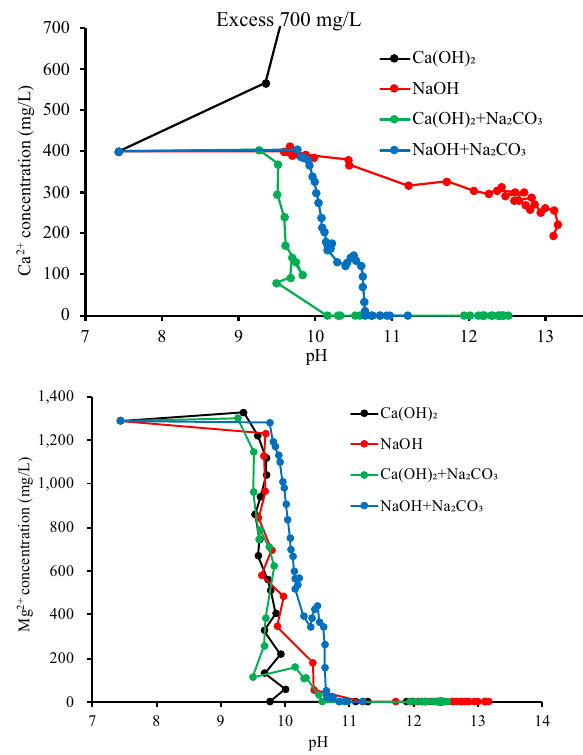
Fig. 1 Concentrations of Ca 2 + (top) and Mg 2 + (bottom) versus pH during softening with ballasted fl occulation (SBF) using different alkaline agents. The alkaline agents were Ca(OH) 2 (dosage = 1.7 mol/L; dosage volume 1 – 32 mL), NaOH (5.0 mol/L; 1 – 22 mL), Ca(OH) 2 + Na 2 CO 3 (Ca(OH) 2 = 1.7 mol/L; Na 2 CO 3 = 2.0 mol/L, 1 – 40mL), and NaOH + Na 2 CO 3 (NaOH = 1.35mol/L; Na 2 CO 3 = 0.675 mol/L, 1 – 72mL).